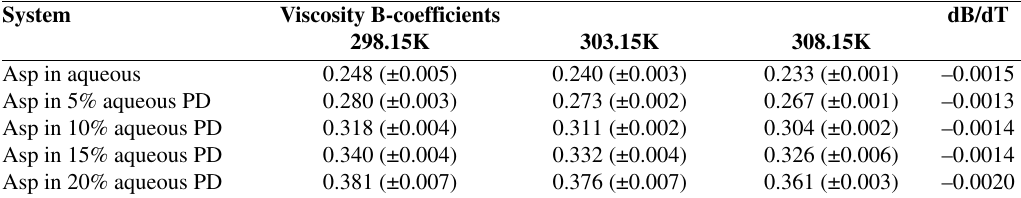
of Asp in aqueous solution of PD at differ- tr,